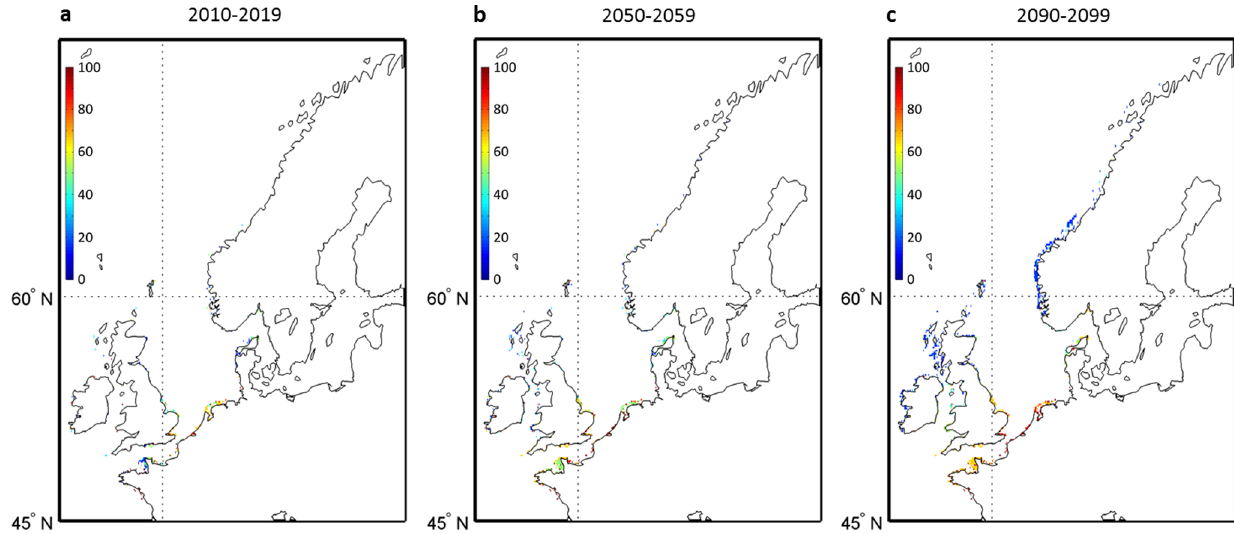
Figure 3. Percentage of models forecasting a disappearance of L.digitata . a, for the decade 2010–2019; b, for the decade 2050–2059 and c, for the decade 2090–2099. In each grid cell, a model is considered to predict the disappearance of the species when the probability of occurrence for the reference period (1982–2009) is higher than 0.05 and lower than this threshold for a given decade.